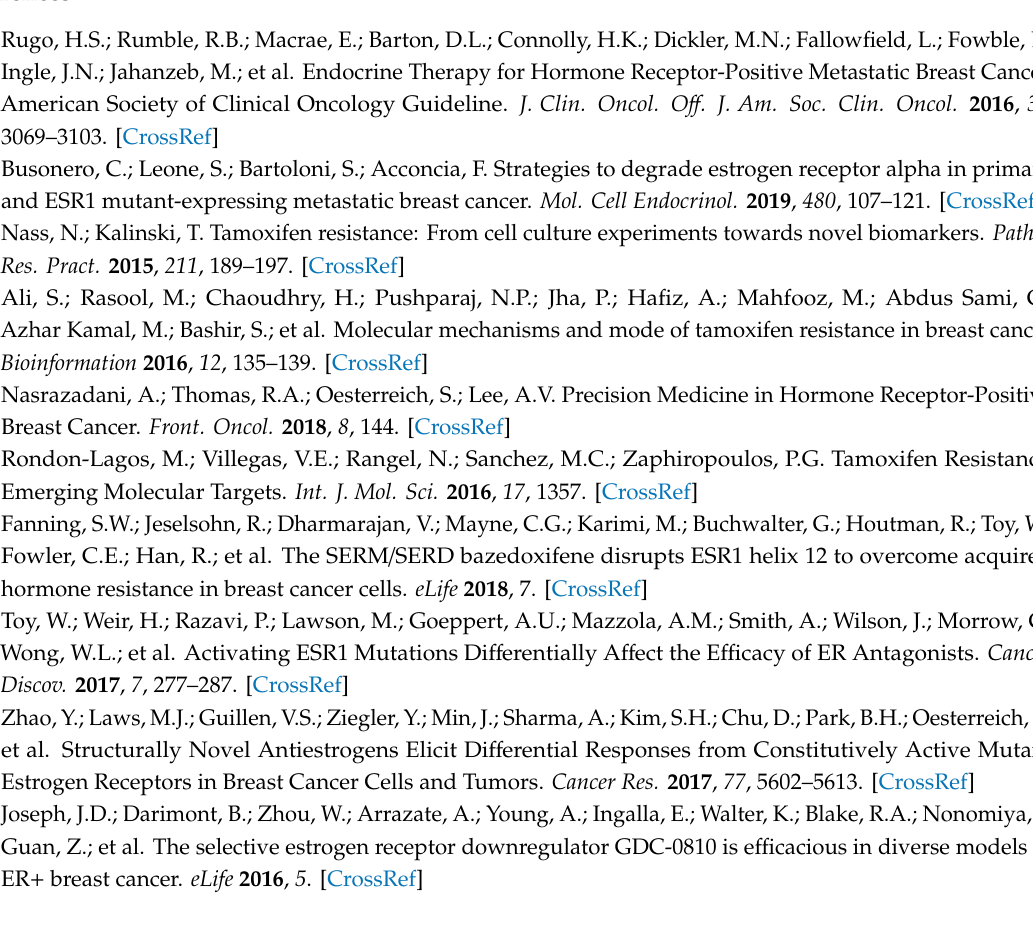
Table S1. OU regulated genes, Table S2. DIGO regulated genes, Table S3. Enriched pathways in OU regulated genes, Table S4. Enriched pathways in DIGO regulated genes, Table S5. Enriched upstream modulator in OU regulated genes, Table S6. Enriched upstream modulator in DIGO regulated genes, Table S7. 20S Proteasome subunit genes (Hugo gene nomenclature commetee www.genenames.org). Figure S1. Ouabain- and digoxin-induced ER α degradation. Figure S2. Ouabain- and digoxin-induced reduction in cell proliferation. Figure S3. Ouabain- and digoxin-induced variation in cell cycle. Figure S4. Validation of the ingenuity pathway analysis upstream regulator in breast cancer cells. Figure S5. Ouabain- and digoxin-induced proteasome activation. Source data: the whole blot (uncropped blots) showing all the bands with all molecular weight markers for all the Western blots shown in the figures as well as the raw data for each